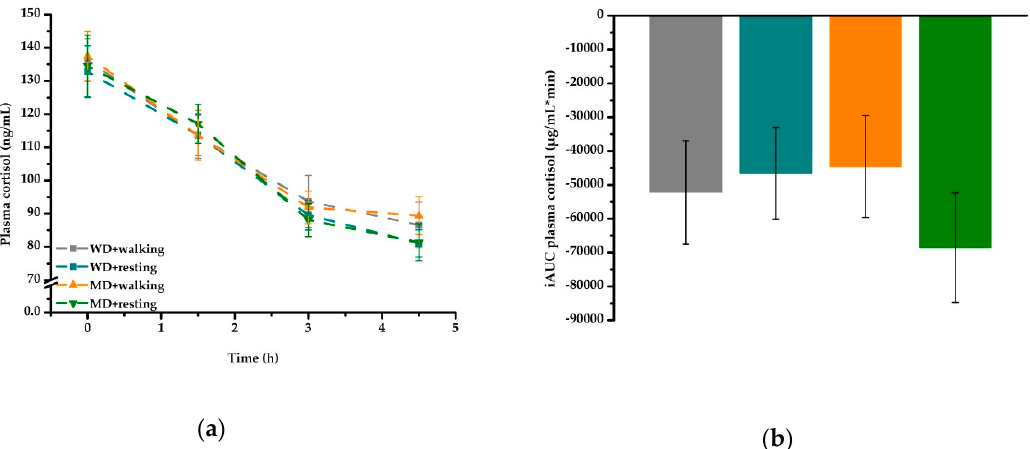
Figure 4. Fasting and postprandial plasma cortisol according to treatment condition: ( a ) postprandial cortisol concentration decreased over time ( P < 0.001) in all four treatment conditions. ( b ) iAUC data revealed no effect of meal or activity. iAUC, incremental area under the curve; MD, Mediterranean-type diet meal; WD, Western diet high-fat meal.